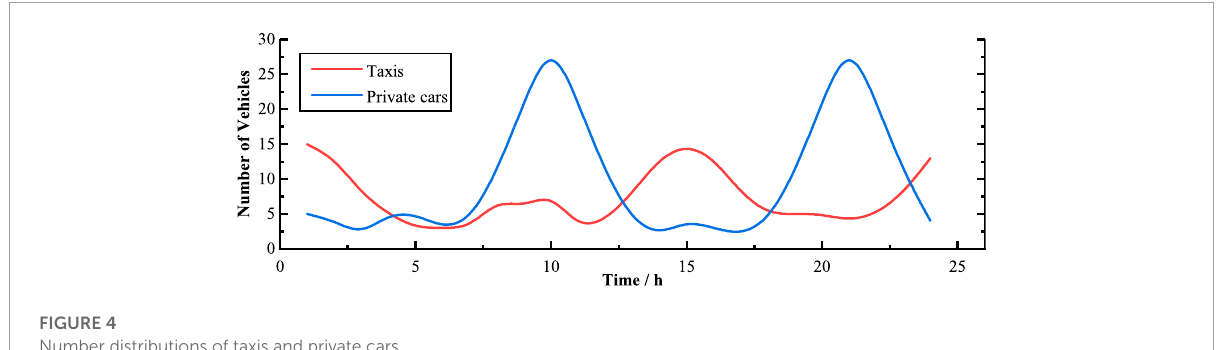
FIGURE 4 Number distributions of taxis and private cars.